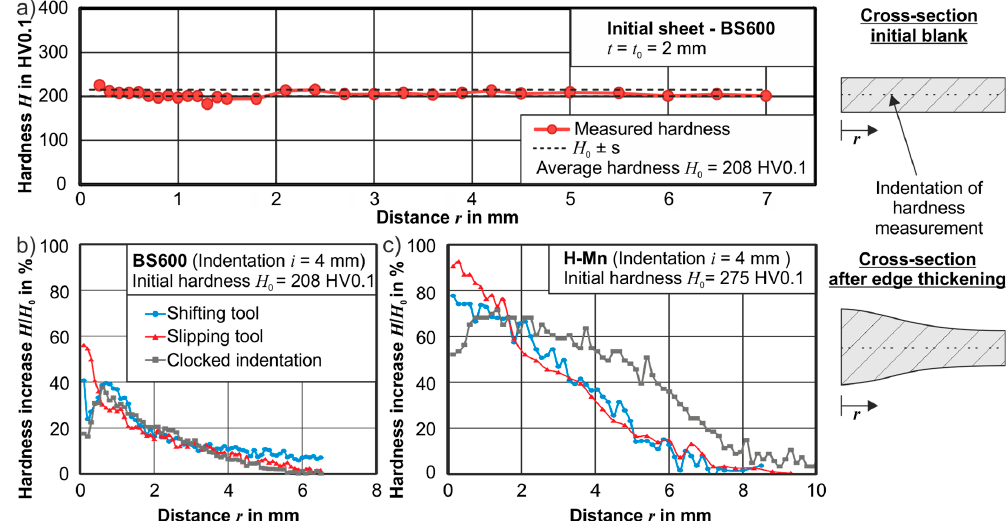
Figure 4. Hardness distribution of the ( a ) initial sheet and edge thickened ( b ) BS600 and ( c ) H-Mn sheets, respectively.